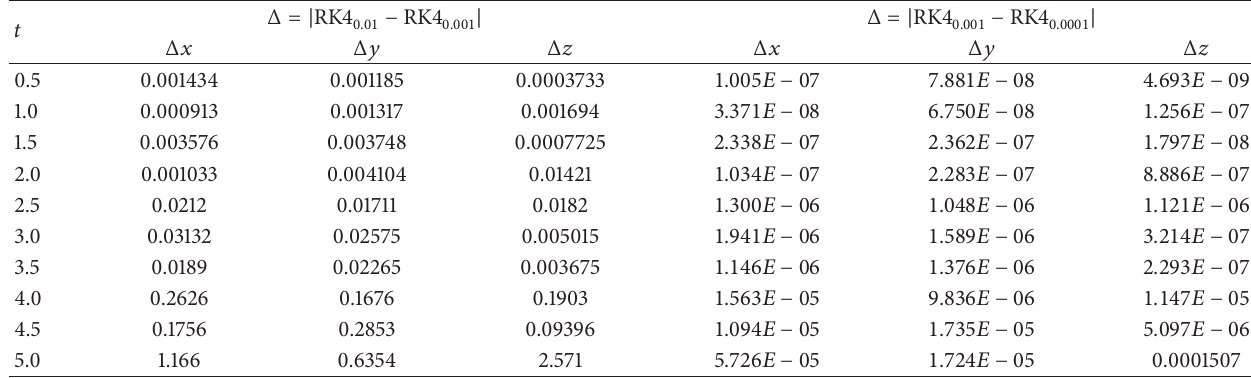
Table 1: Determination of accuracy of RK4 for chaotic L¨u system.